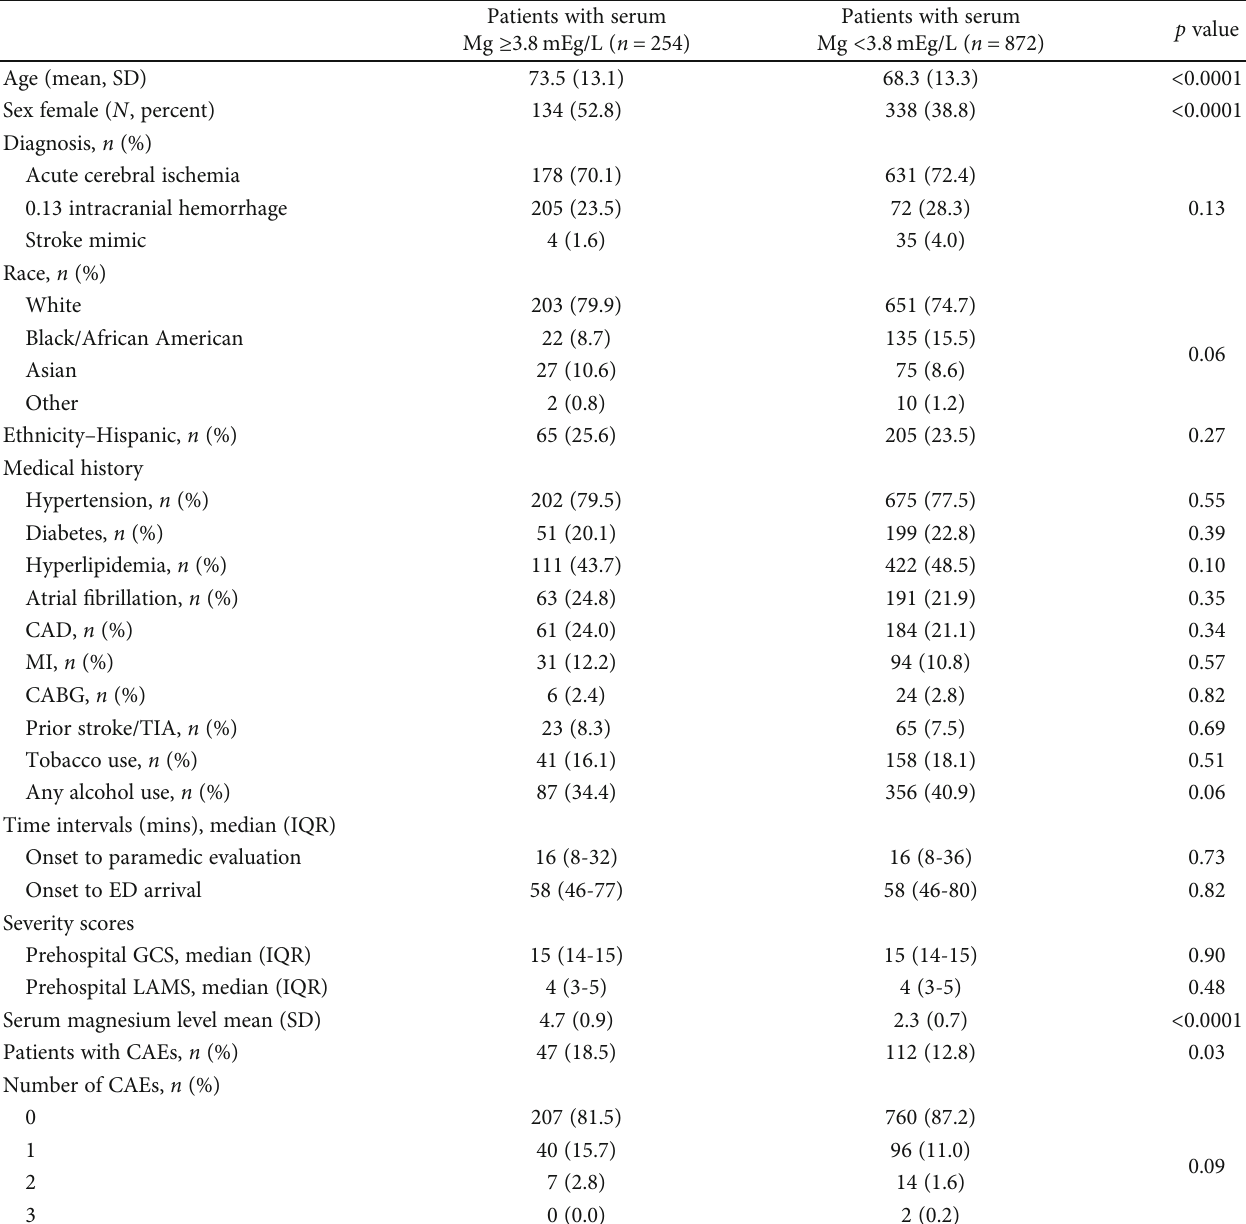
Table 2: Dichotomized demographic and clinical characteristics of patients who achieved and did not achieve blood serum magnesium study target within 72 hours (3.8